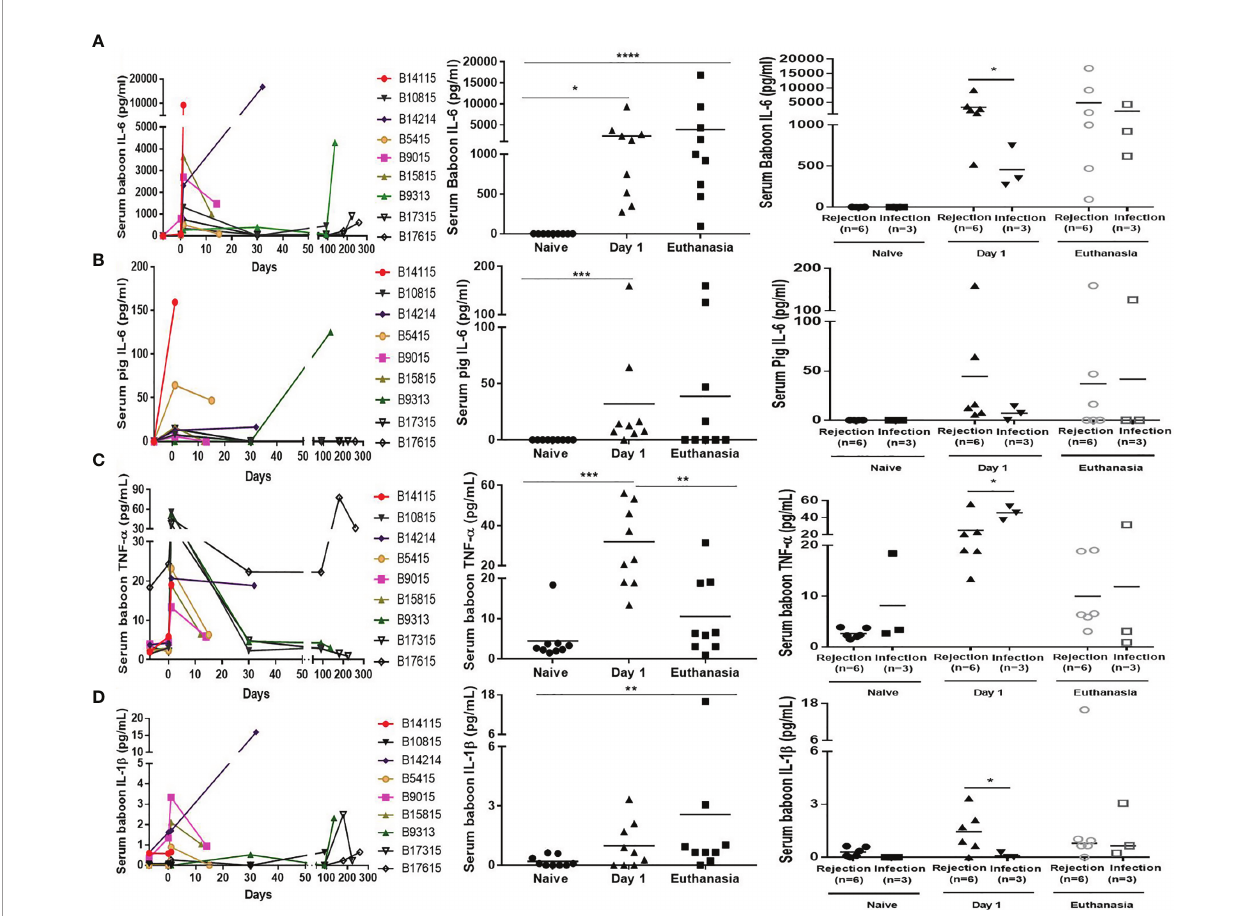
FIGURE 4 | Levels of serum cytokines in baboons with pig kidney graft. (A) Levels of serum baboon IL-6 in the baboons (n=9) at different time-points (Left); The difference of serum baboon IL-6 in the baboons (n=9) (Middle), and between the rejection (n=6) and infection (n=3) groups at pre-Tx (naïve), day 1 after operation, and at euthanasia (Right). (B) Levels of serum pig IL-6 in the baboons (n=9) at different time-points (Left); The difference of serum pig IL-6 in the baboons (n=9) (Middle), and between the rejection (n=6) and infection (n=3) groups at pre-Tx (naïve), day 1 after operation, and at euthanasia (Right). (C) Levels of serum TNF- a in the baboons (n=9) at different time-points (Left); The difference of serum TNF- a in the baboons (n=9) (Middle), and between the rejection (n=6) and infection (n=3) groups at pre-Tx (naïve), day 1 after operation, and at euthanasia (Right). (D) Levels of serum IL-1 b in the baboons (n=9) at different time-points (Left); The difference of serum IL-1 b in the baboons (n=9) (Middle), and between the rejection (n=6) and infection (n=3) groups at pre-Tx (naïve), day 1 after operation, and at euthanasia (Right). (*p < 0.05, **p < 0.01, ***p < 0.001, ****p <